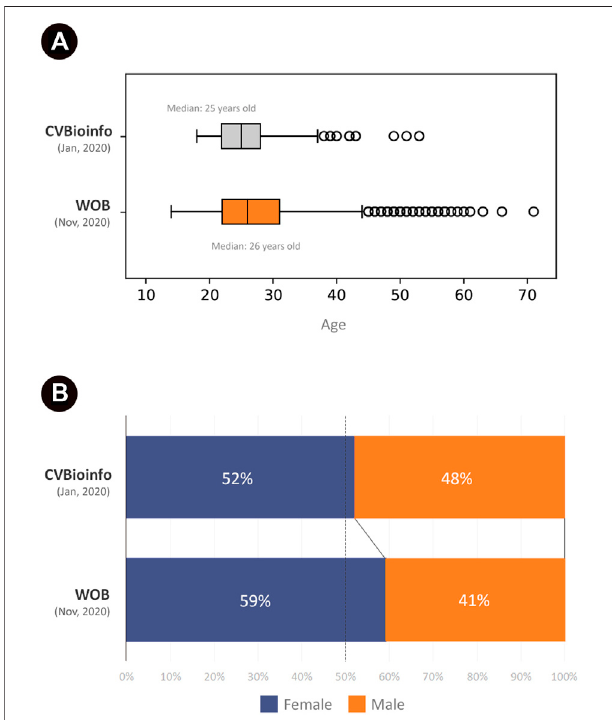
FIGURE 3 | Attendees grouped by age and sex. Total attendees: WOB 2,727; CVBioinfo 221. (A) Quartile (0.25, 0.5, 0.75): 22, 26, and 31 (WOB); 22, 25, and 28 (CVBioinfo). Mode: 22 (WOB) and 25 (CVBioinfo). Mean: 27.46 (WOB) and 26.44 (CVBioinfo). Median: 26(WOB) and 25(CVBioinfo). Max value:71(WOB)and53(CVBioinfo).Minvalue:14(WOB)and18(CVBioinfo). (B) Male/Female proportion in CVBioinfo (upper stacked bar) and WOB (lower stacked bar). Conecting line between bars indicate change in